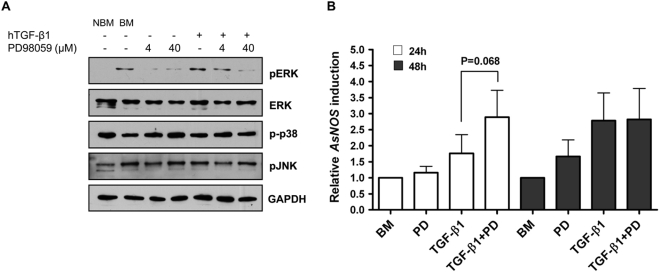
PD98059 inhibited TGF-β1-induced ERK phosphorylation and enhanced TGF-β1-induced NOS expression in the A. stephensi midgut.(A) PD98059 inhibited ERK activation in mosquito midgut. Anopheles stephensi mosquitoes were fed on artificial bloodmeals supplemented with 2000 pg/ml TGF-β1 with or without 4 or 40 µM PD98059. At 20 min after completion of feeding, 100 midguts from each treatment group were dissected and prepared for immunoblot analysis. Protein lysate concentrations were measured by BCA assay; equal amounts of protein were loaded in each lane. The immunoblot is representative of 3 independent experiments. (B) Inhibition of ERK phosphorylation enhanced TGF-β1-induced NOS expression in vivo. Anopheles stephensi were fed on artificial bloodmeals supplemented with 40 µM PD98059 (PD), 2000 pg/ml TGF-β1, or 40 µM PD98059 and 2000 pg/ml TGF-β1 (TGF-β1+PD). A control group (BM) was provided an identical unsupplemented artificial bloodmeal. Previous studies confirmed that provision of small volumes of PBS and DMSO has no effect on AsNOS expression in vivo (not shown), so these treatments were not included here. AsNOS expression levels were analyzed from midguts (n = 15) collected at 24 h or 48 h after blood feeding from each treatment group. The data are represented as means±standard errors from 5 independent experiments for fold inductions compared with the PBS control. The data were analyzed by ANOVA for overall significance and Student's t-test was used for the pairwise comparison at 24 h.